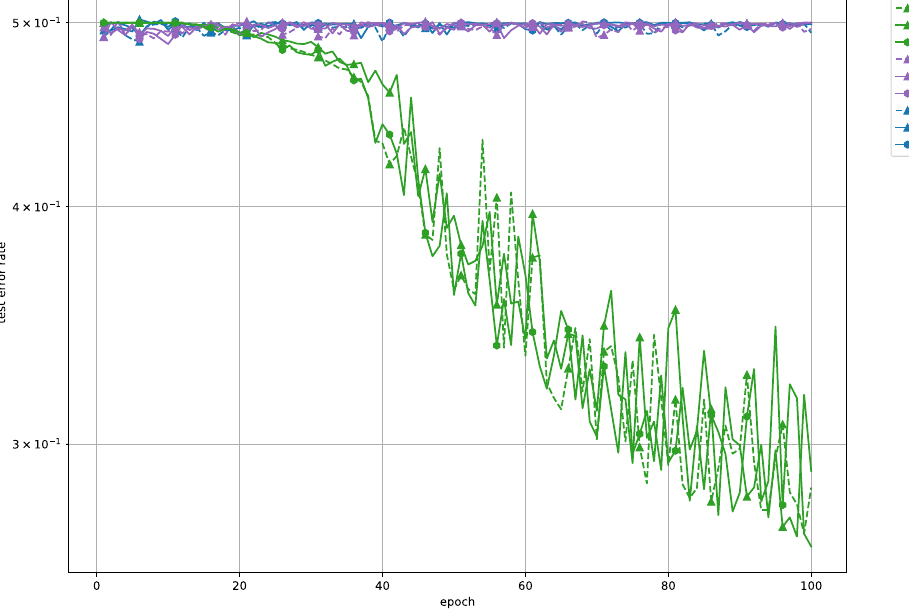
Figure 12. Classification error rate versus number of epochs on the IMDb dataset for testing